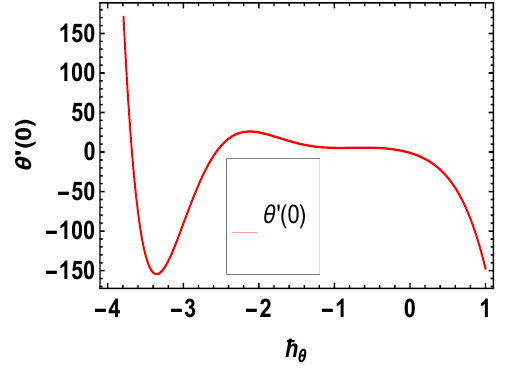
Figure 3. Outcomes of ¯ h θ for θ (cid:48) ( 0 ) .